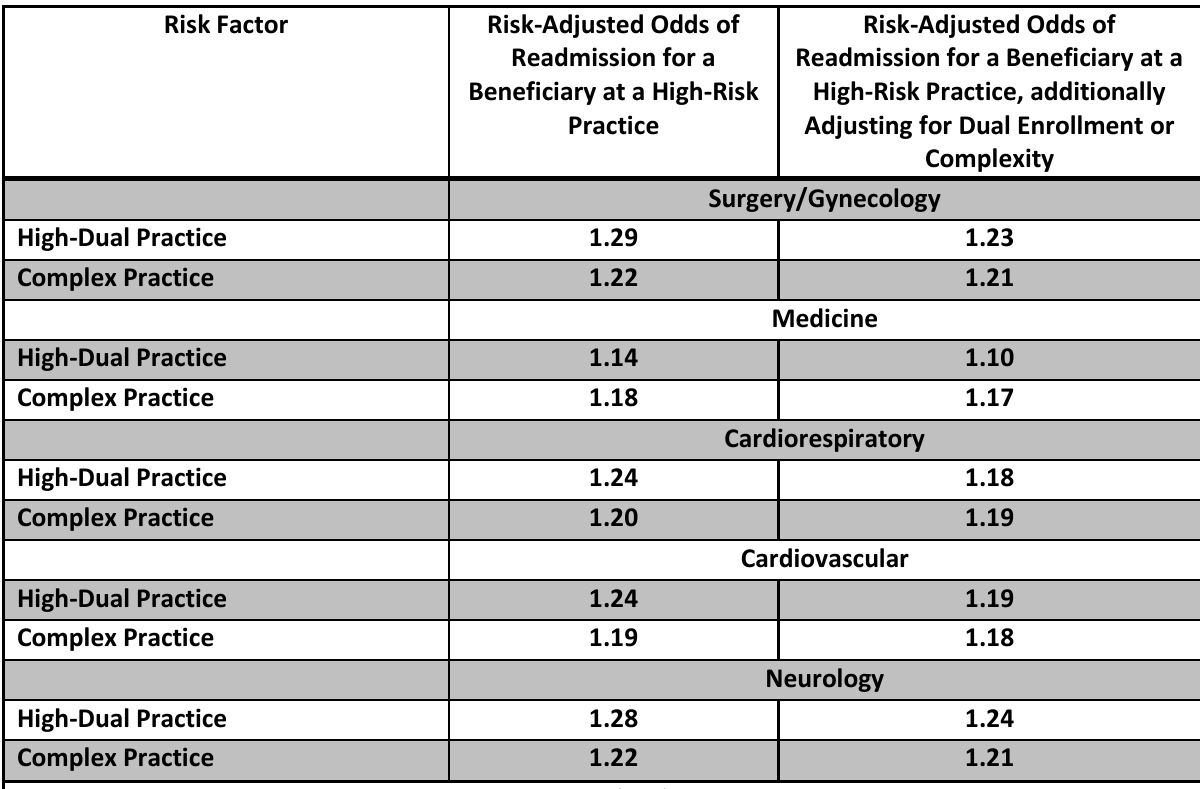
Table 10.8. Practice Factors in